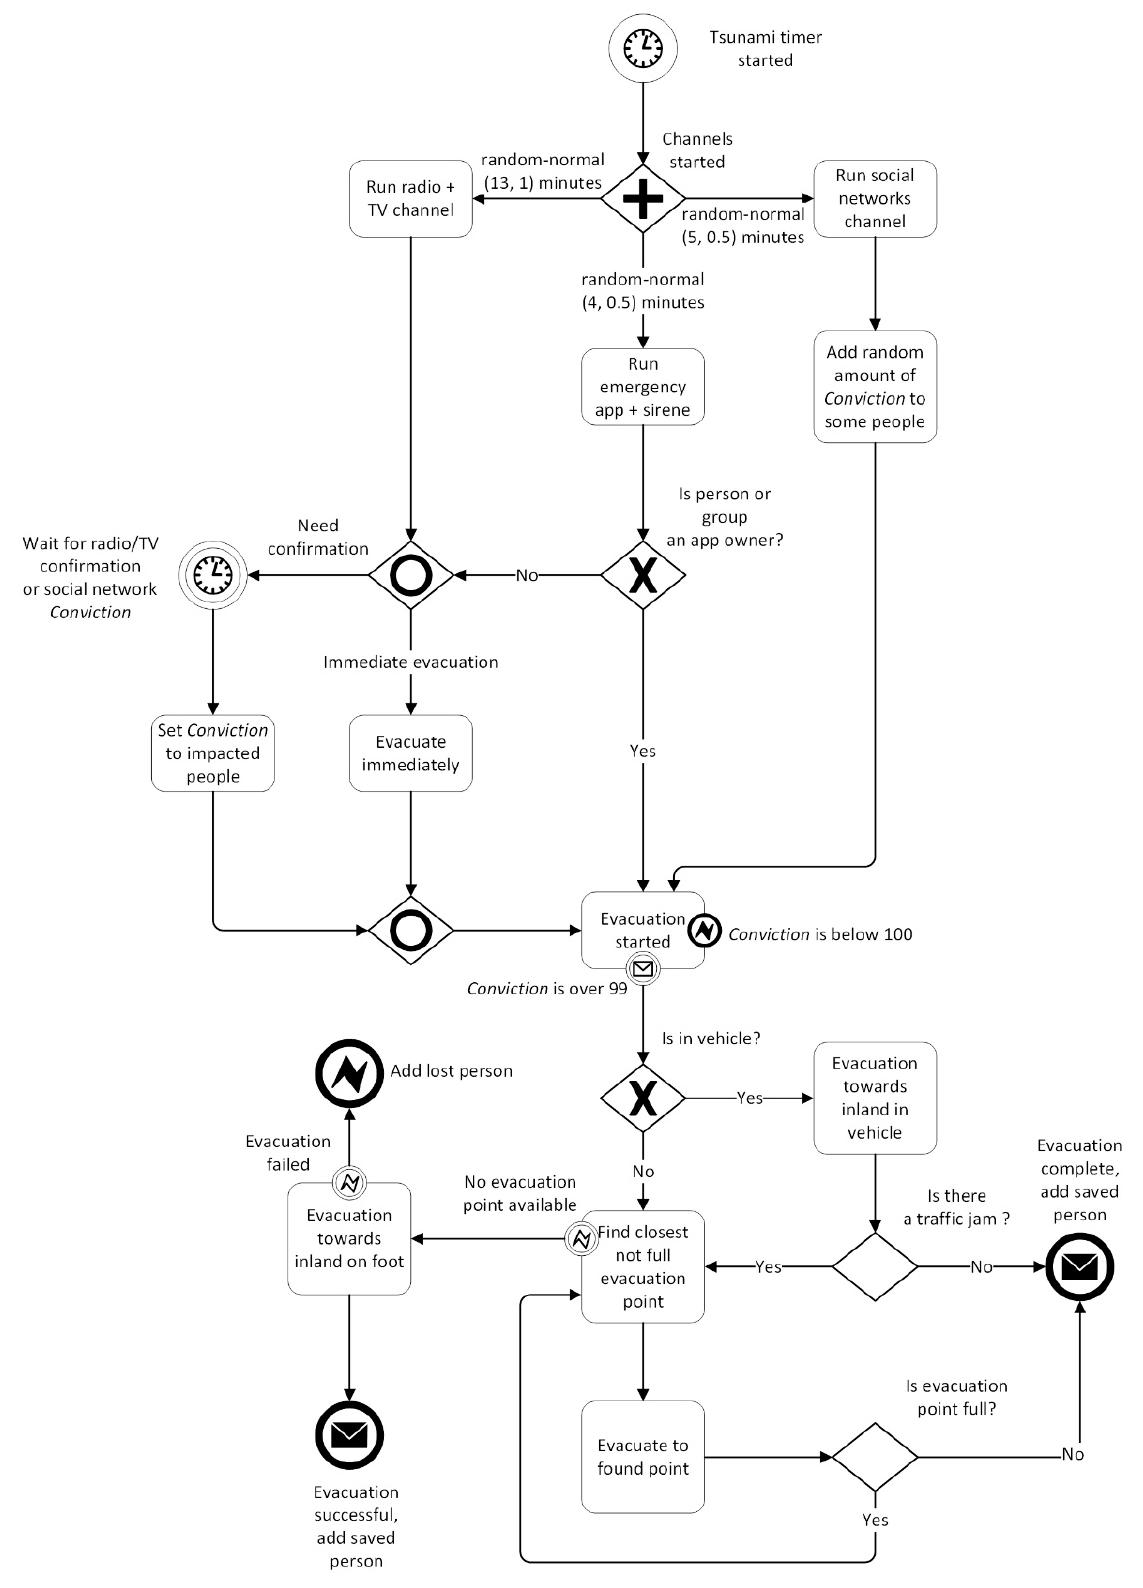
Figure 11. Simulated evacuation process overview using BPMN notation.